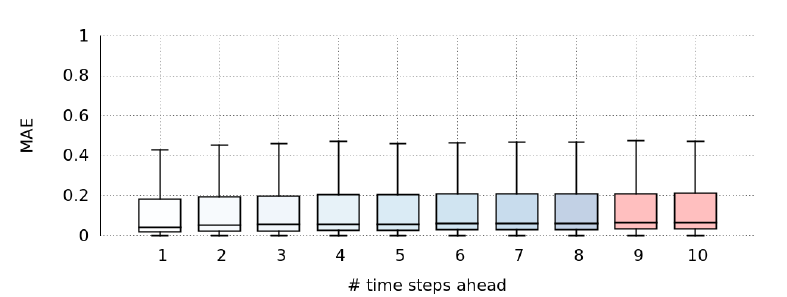
Figure 16. RBR Mean Absolute Error of EtEQ predictions, depicted as a box